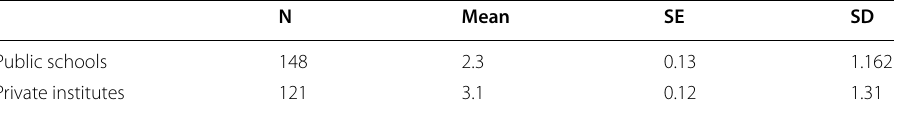
Table 3 Means and standard deviations of WTC items